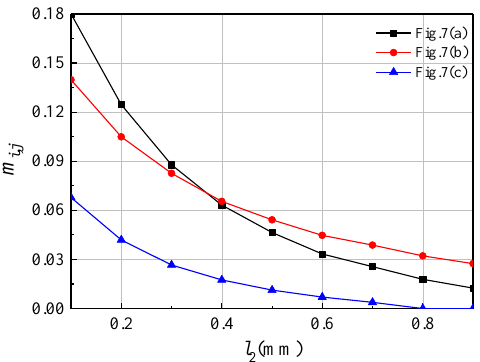
Figure 7. Coupling coefficient between the resonators of type II.